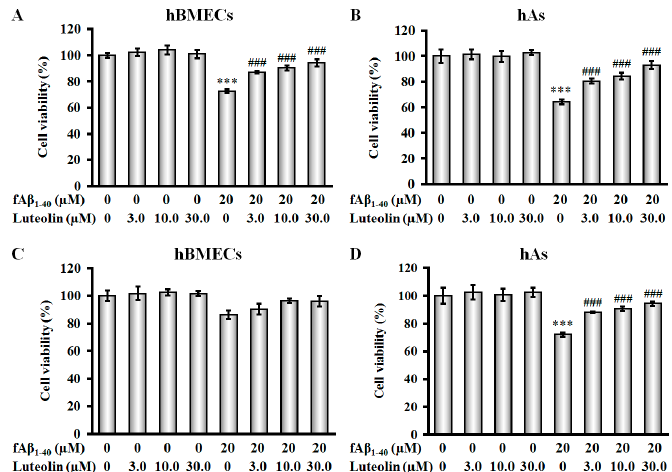
Figure 2. Cytoprotective effects of luteolin on human brain microvascular endothelial cells (hBMECs), human astrocytes (hAs) and co-culture against fibrillary amyloid- β peptide 1-40 (fA β 1–40 )-induced toxicity. ( A ) Luteolin increases cell viability of hBMECs as evaluated by a 3-(4,5-dimethylthiazol-2-yl)-5-(3-carboxymethoxy-phenyl)-2-(4-sulfophenyl)-2 H -tetrazolium (MTS) assay. n = 8; ( B ) Luteolin increases cell viability of hAs as evaluated by MTS assay. n = 8; ( C ) Luteolin has a mild effect on cell viability of hBMECs in the co-culture as evaluated by Alamar blue assay. n = 6; ( D ) Luteolin influences cell viability of hAs in the co-culture as evaluated by Alamar blue assay. n = 6. Data are expressed as the mean ± standard error of mean (SEM); *** p < 0.001 vs. control; ### p < 0.001 vs. fA β 1–40 .